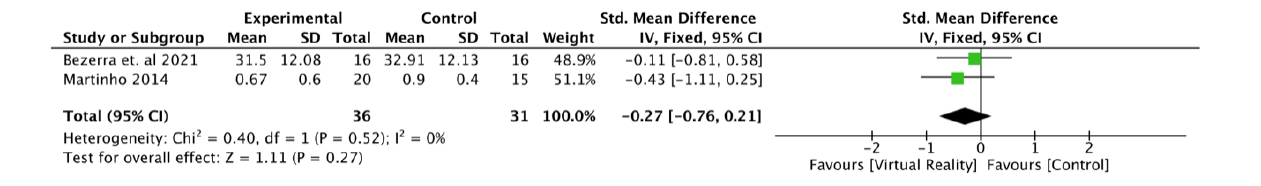
Figure 4. Comparison of experimental and control, according to dynamometry. SD: standard deviation; 95% CI: 95% confidence interval.